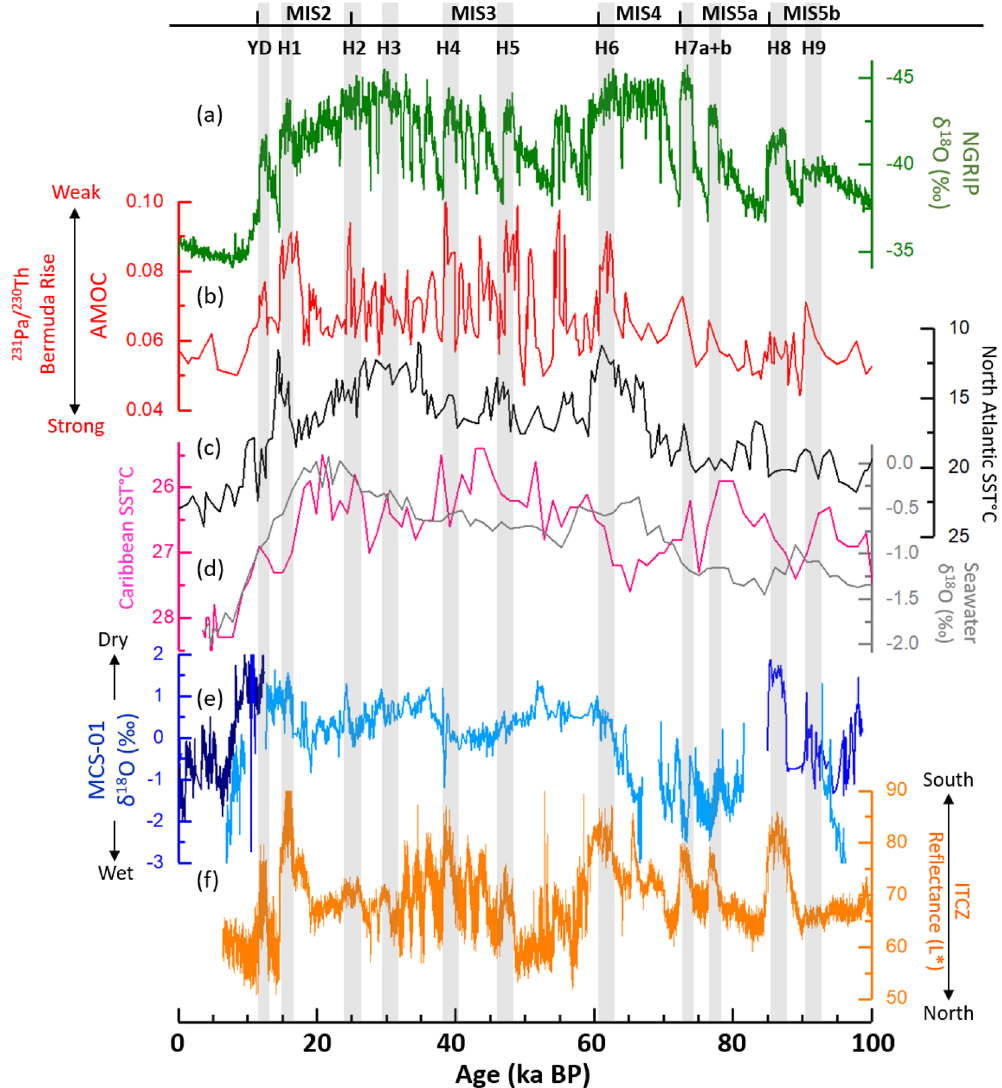
Figure 7. Comparison of the Western Cuban speleothem records (normalized data) (e) by Fensterer et al. 6 (dark blue), Warken et al. 13 (light blue) and this study (blue), with the North Greenland Ice Core Project ( a ) 23–28 , the Bermuda Rise 231 Pa/ 230 Th as a proxy of AMOC strength ( b ) 18,20,21 , the North Atlantic SST from core SU90-03 ( c ) 48 , the Caribbean Sea Surface Temperature (SST) and δ 18 O records ( d ) inferred from planktonic foraminifera from the sediment core ODP 999A 16 , and the reflectance record from the sediment core MDO3- 2621 ( f ) from the Cariaco Basin reflecting ITCZ movements 17 . Gray bars indicate the timing of the North Atlantic abrupt cooling episodes (Heinrich